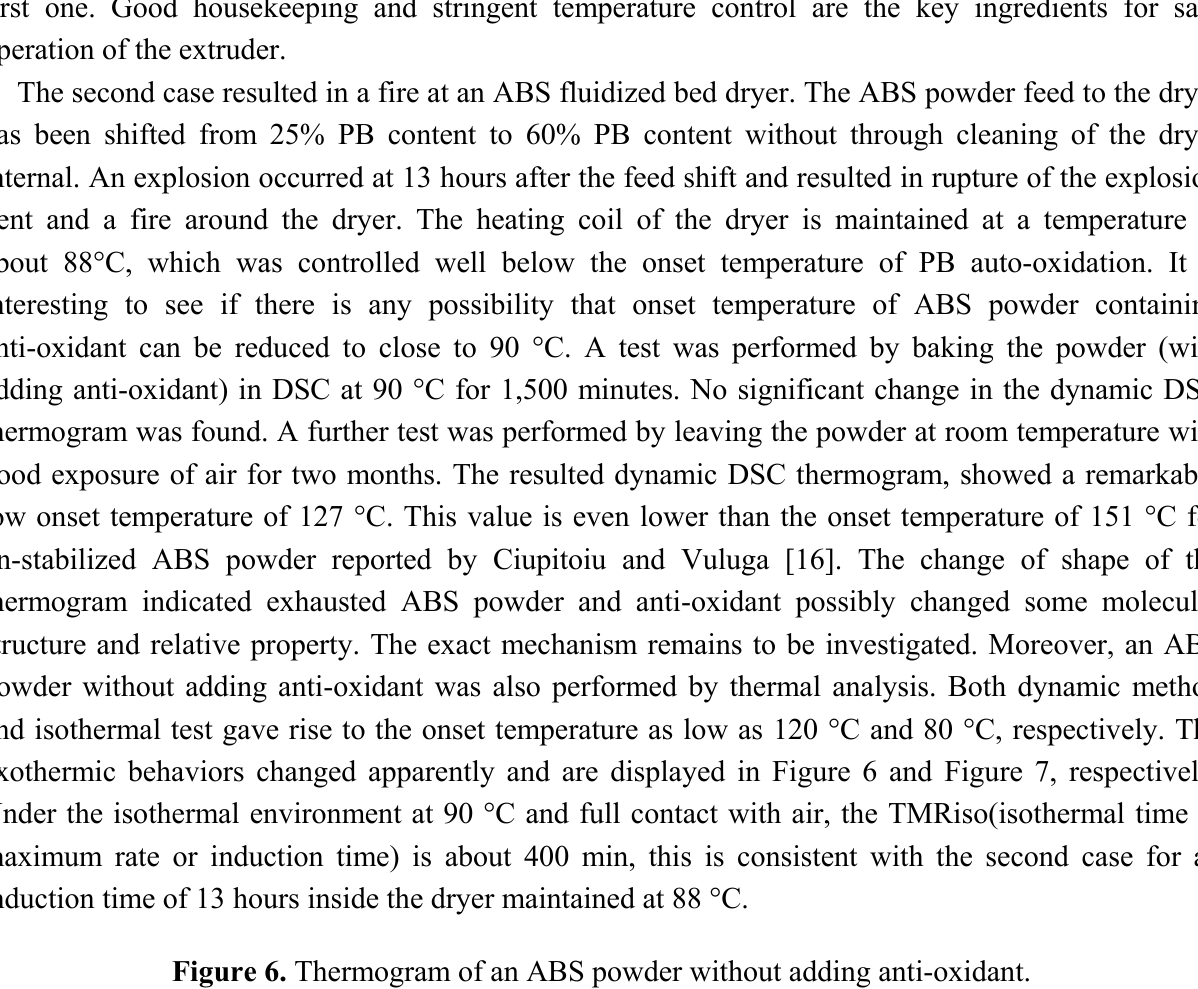
Figure 6. Thermogram of an ABS powder without adding